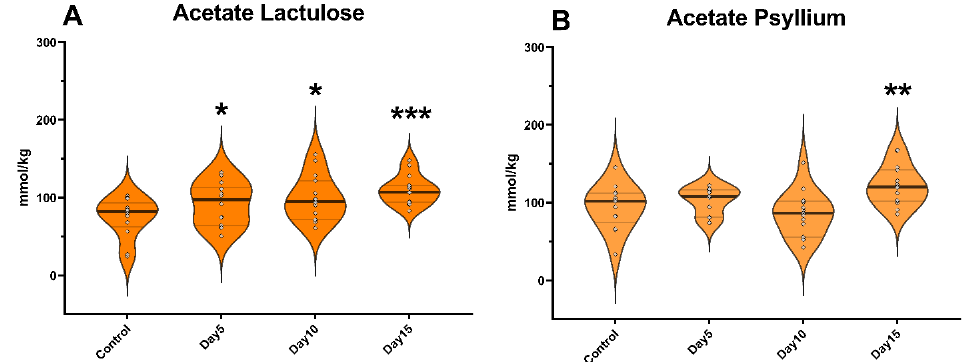
Figure 2. Violin plots show the acetate concentration in the fecal samples following lactulose ( A ) and psyllium ( B ) treatment measured by GC-MS method. Data are visualized using violin plots. Concentrations of single samples are plotted as gray dots; black line refers to the median and gray lines refer to first and third quartiles. * p < 0.05, ** p < 0.01, *** p < 0.001.